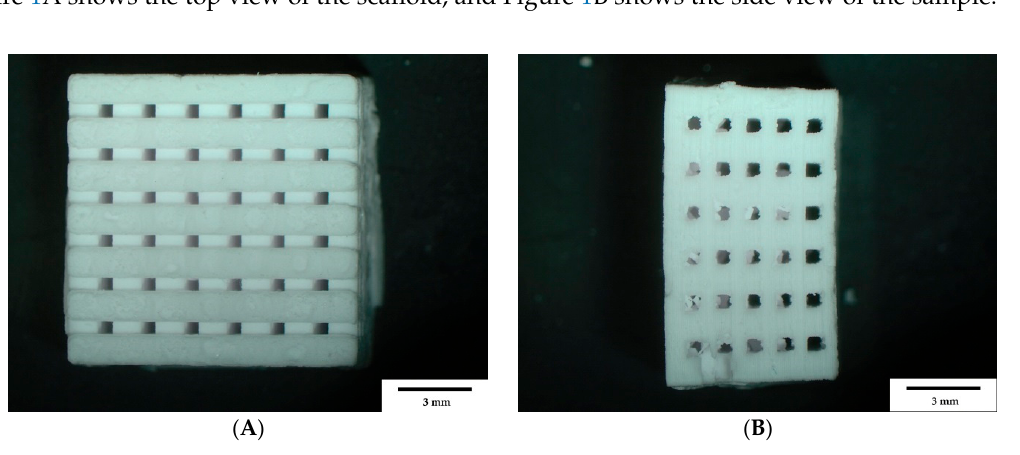
Figure 1. β -TCP scaffold (500 µm) through a stereomicroscope (Olympus SZ61). A : Top view; and B : Side view. Scale bar = 3mm; magnification: 0.67× .